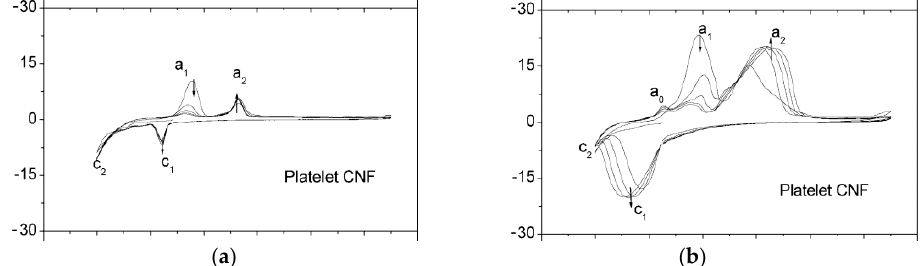
Figure 11. Cyclic voltammetry for Fe/C composite electrodes composited carbon nano-fibers ( a ) without and ( b ) with FeS additive [54] (Copyright © 2006, Elsevier).